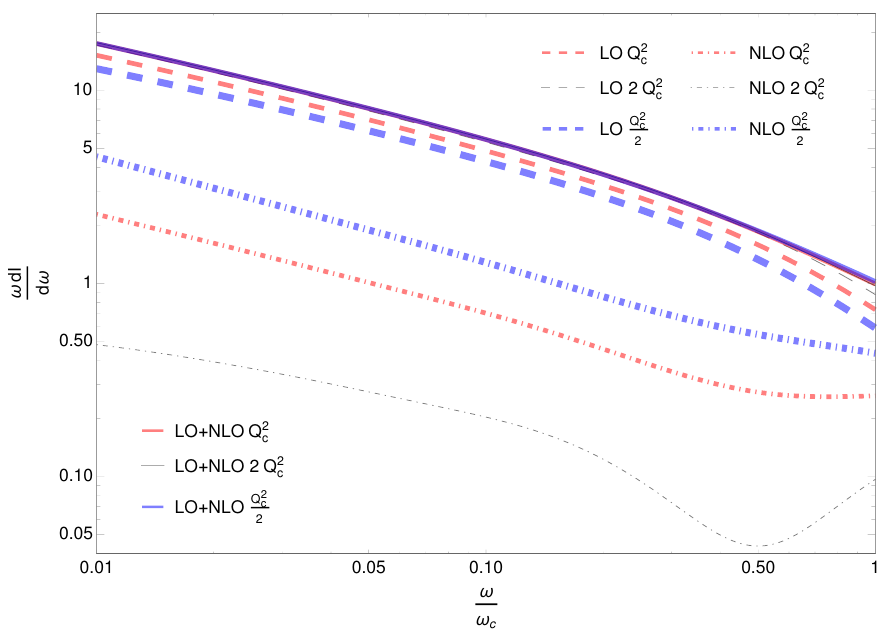
Figure 3 . Calculation of the IOE at NLO accuracy, while (cid:12)xing the matching scale Q 2 = Q 2 and varying this by Q 2